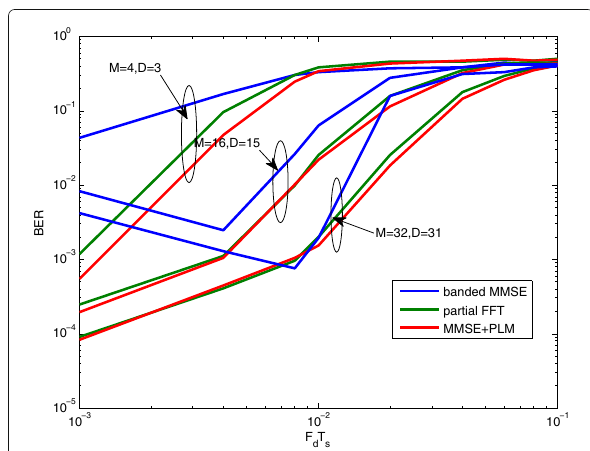
Fig. 8 BER performance against normalized Doppler frequencies, N